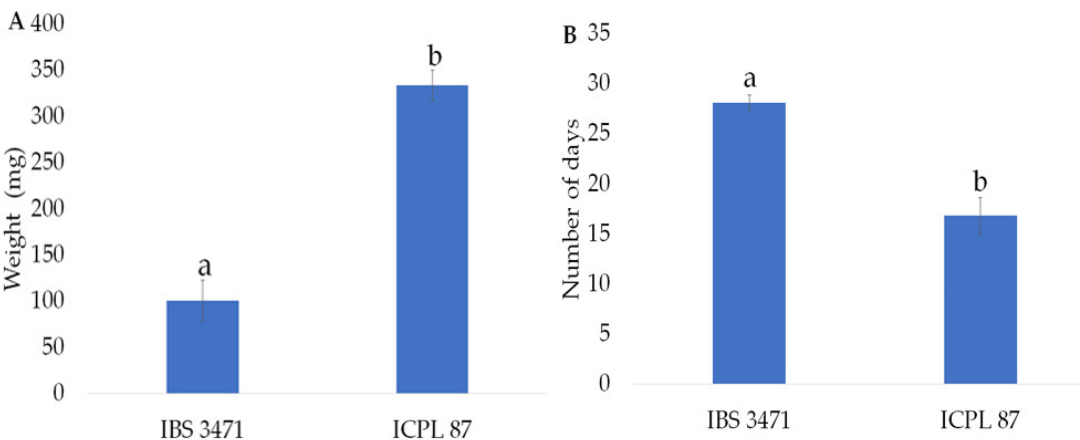
Figure 1. Average larval weight and larval lifecycle of H. armigera from detached intact leaf bioassay on C. scarabaeoides (IBS 3471) and C. cajan (ICPL 87). ( A ) Average larvae weight (mg) by day eight. ( B ) The average number of days from neonate larvae to pupa formation. Values labelled with different letters are significantly different at p < 0.05 ( t -test). All data are means ± standard errors ( n = 10).